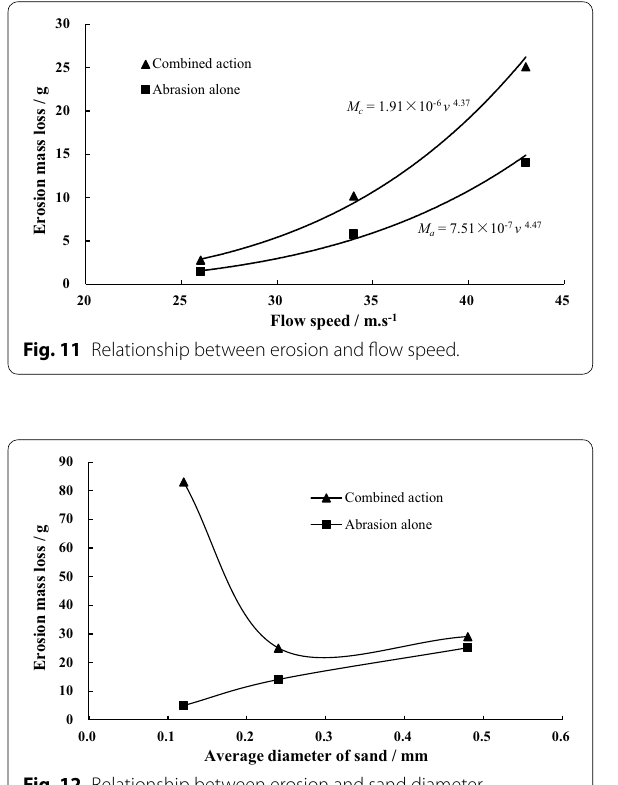
Fig. 12 Relationship between erosion and sand